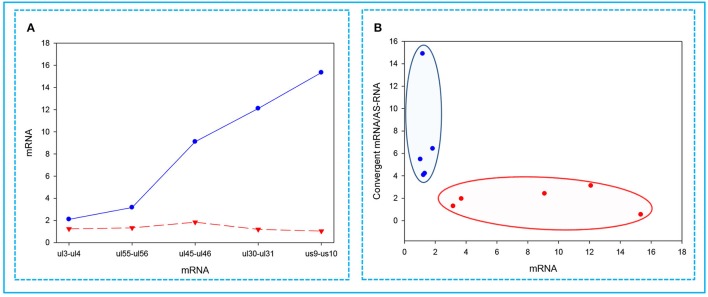
Correlations between the expressions of convergent HSV genes. The relative copy numbers (Rx values) were calculated for the transcripts encoded by five convergent gene pairs: ul3-ul4; ul30-ul31; ul45-ul46; ul55-ul56; us9-us10. (A) The less abundant mRNAs encoded by one of the convergent gene pairs are indicated by a red dashed line, while the more abundant partner mRNAs are depicted by a blue solid line. The figure shows that the higher the relative abundance of a transcript in the total PRV transcriptome, the lower the level of mRNA produced from the convergent gene. (B) Cluster analysis of the Rx values of the examined mRNAs compared to the ratio between the mRNA/antisense transcripts produced by the convergent gene partner. This figure shows that if a high mRNA levels are produced from a gene, then it exerts a decrease of mRNA/asRNA ratio for the convergent gene. The reason for this is that asRNAs are supposed to be produced as a result of transcriptional read-throughs from the oppositely-oriented genes. The blue dots illustrate low-abundance, while the red dots represent the high-abundance mRNAs.